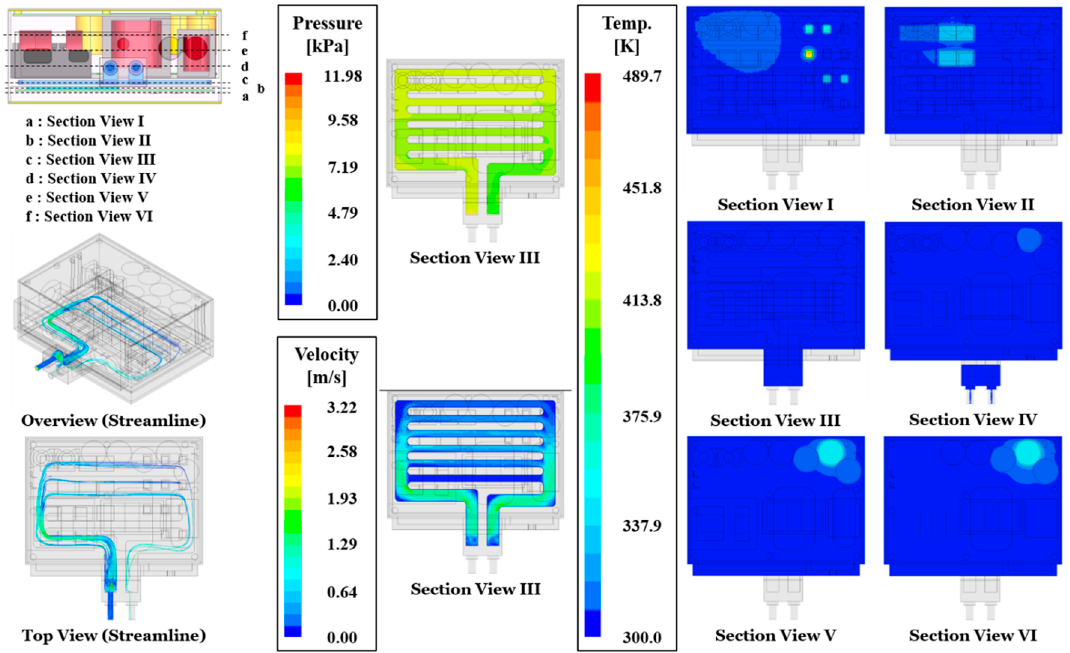
Figure 10. Streamline, pressure, velocity, and temperature distribution in the module for a cooling water flow rate of 6 LPM over a time period of 4000 s in Operating Mode 2.